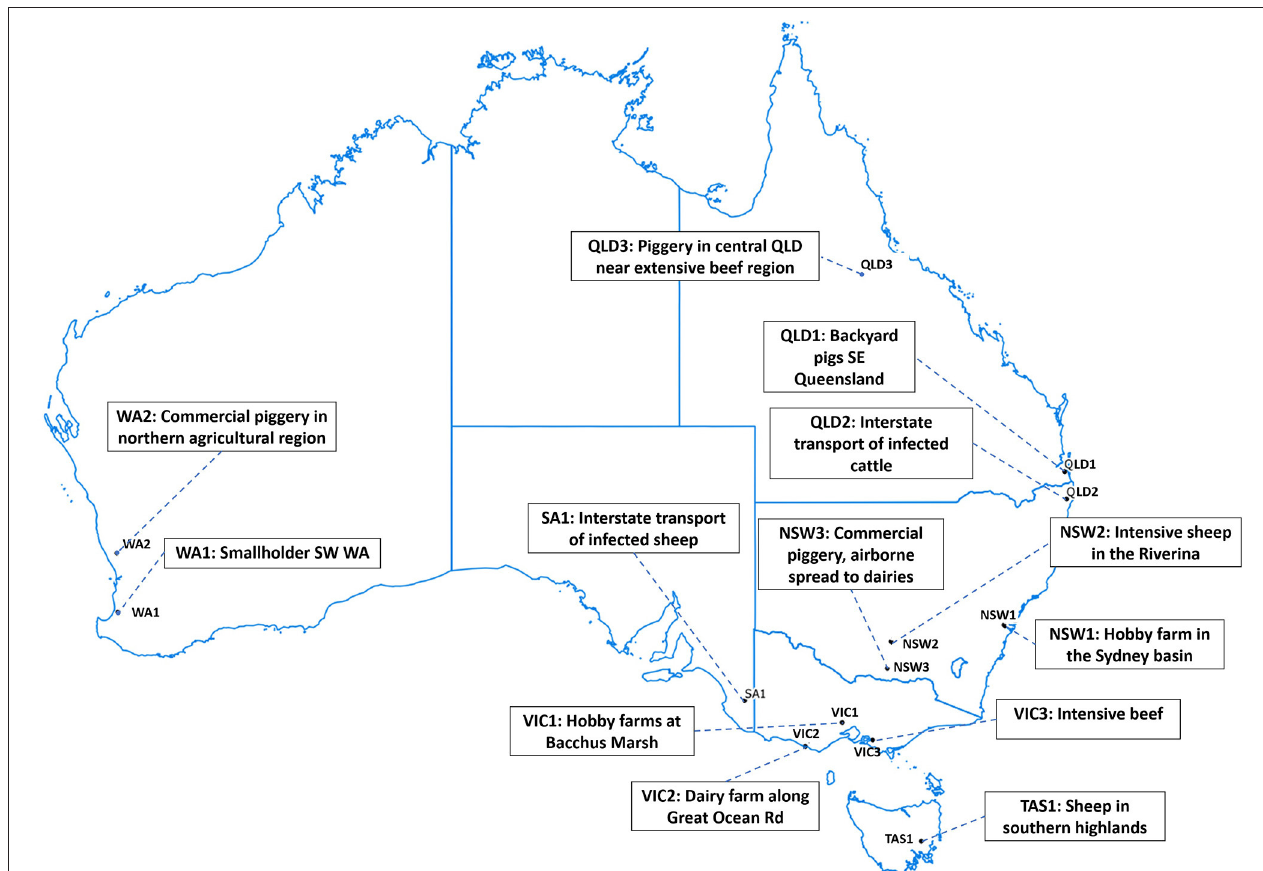
FIGURE 1 | Locations of seed herds for each incursion